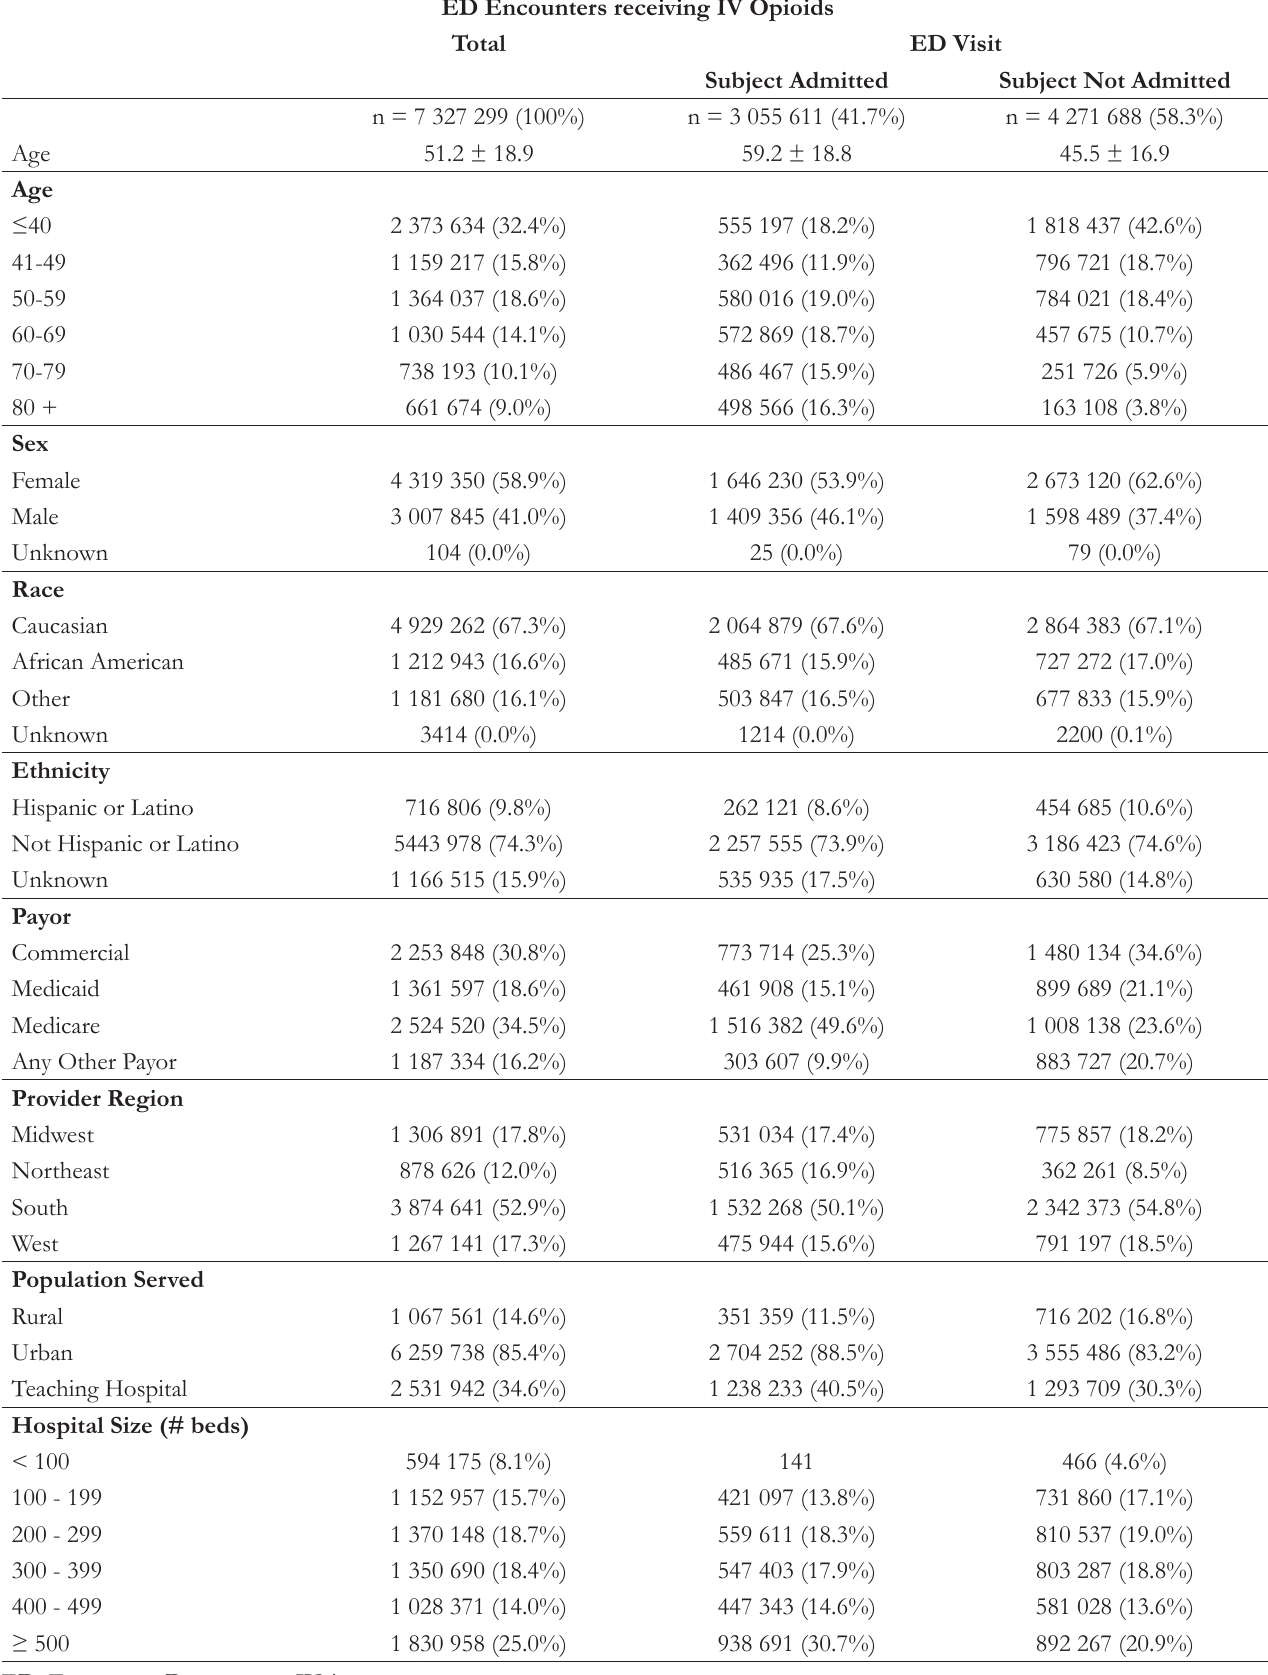
Table 3. Demographics of Patients receiving IV Opioids in the ED and Hospitals providing ED